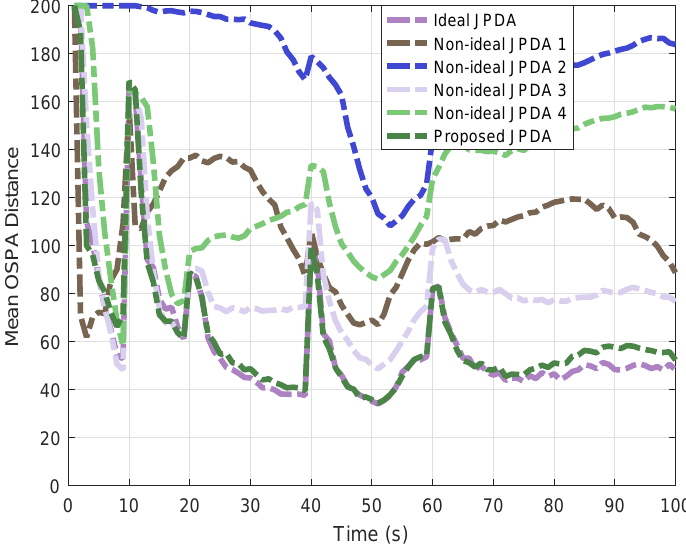
Figure 4. Monte-Carlo results of mean OSPA distance.